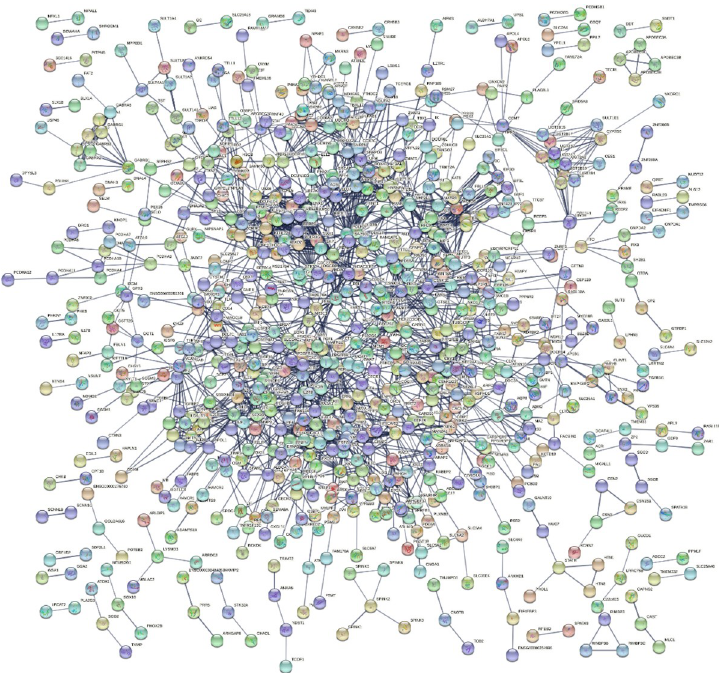
Fig 7. STRING protein network analysis with hidden disconnected nodes in the network. High confidence 0.7, it is full network (the edges indicate both functional and physical protein associations).